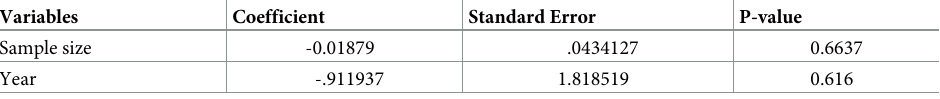
Table 2. Univariate meta-regression of factors related to the heterogeneity of food handling practices among food handlers at food service establishments in Ethiopia,